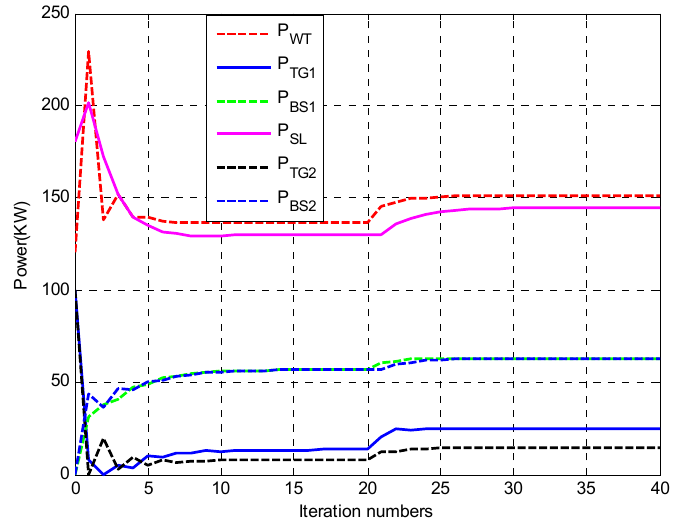
Figure 10. Power output of each node of the multi-period in the AC / DC hybrid microgrid.